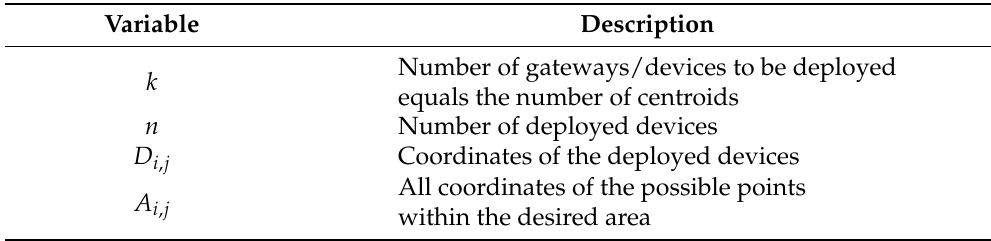
Table 4. The variables that were used in the K-means clustering model, including the input parameters. Variable